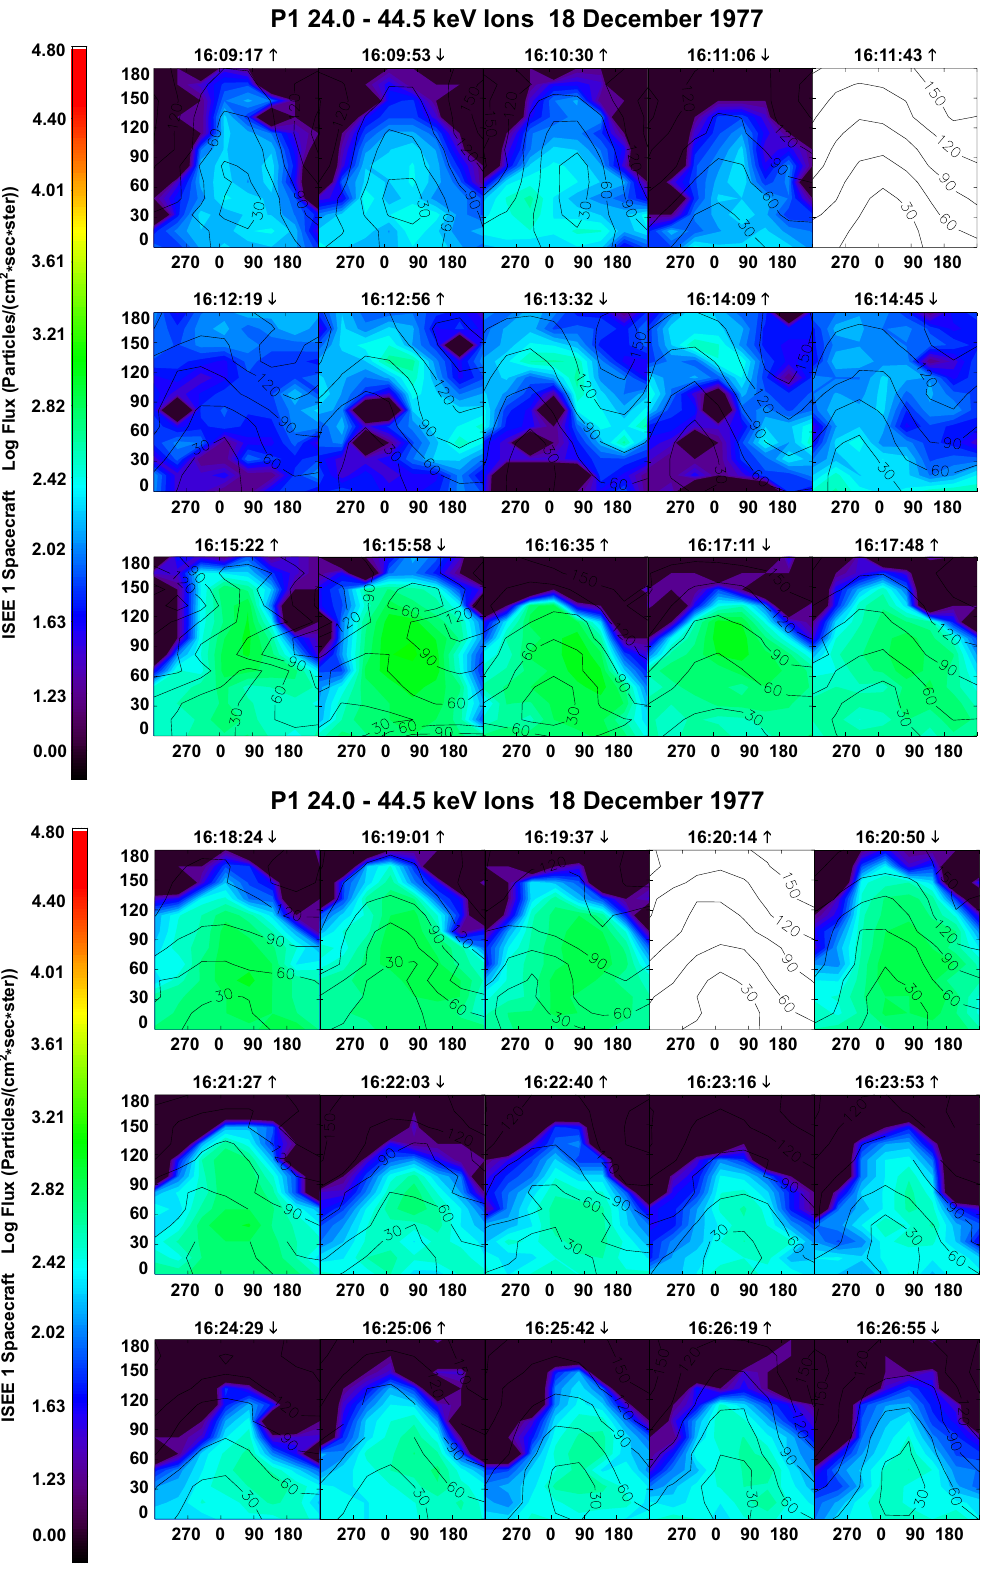
Fig. 13. A time sequence of southern hemispheric PADs for 24 to 44keV ions on 18 December 1977 (Day352) from (a) 16:09:17UT